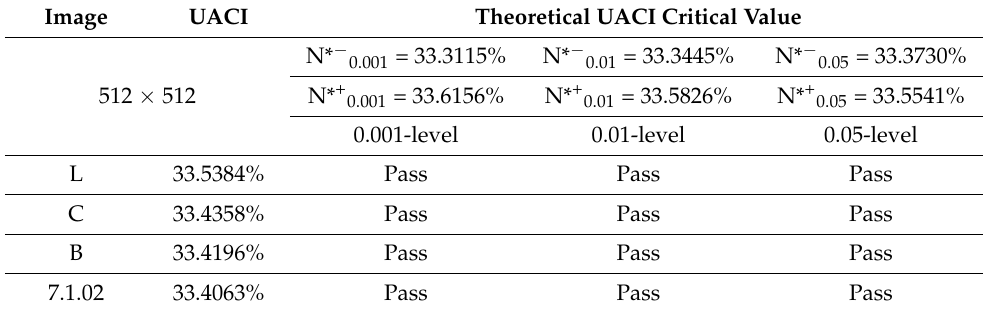
Table 3. The UACI statistical test on key sensitivity.